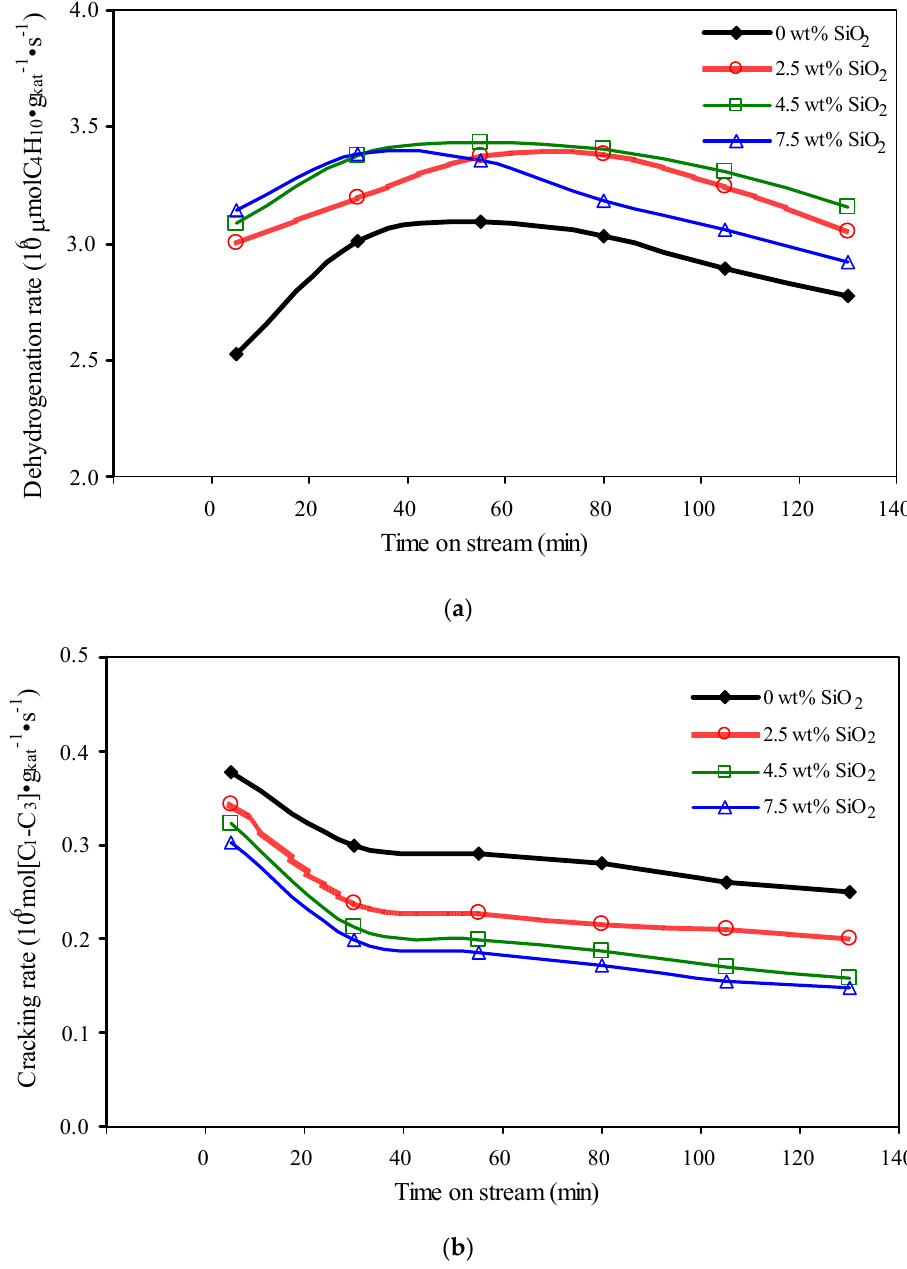
Figure 14. Dehydrogenation rate ( a ) and cracking rate ( b ) versus time on stream.